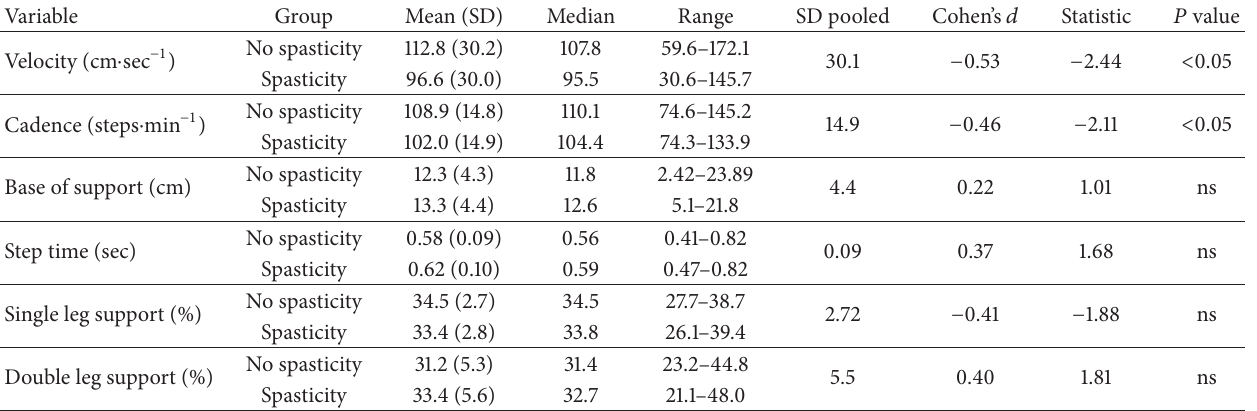
Table 3: Descriptive and effect size data for differences in spatial and temporal parameters of gait between the samples of persons who have multiple sclerosis with ( 𝑛 = 44 ) and without ( 𝑛 = 40 ) leg